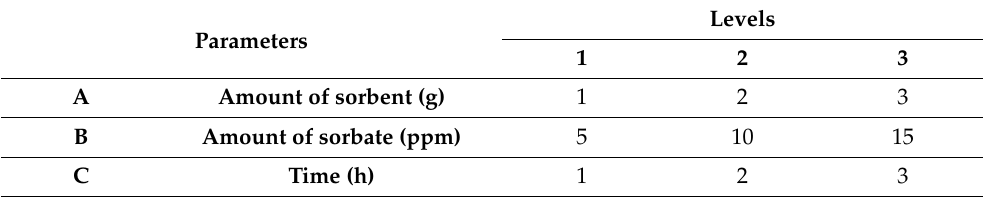
Table 6. Parameters selected for biosorption of Pb and Cr and their levels.